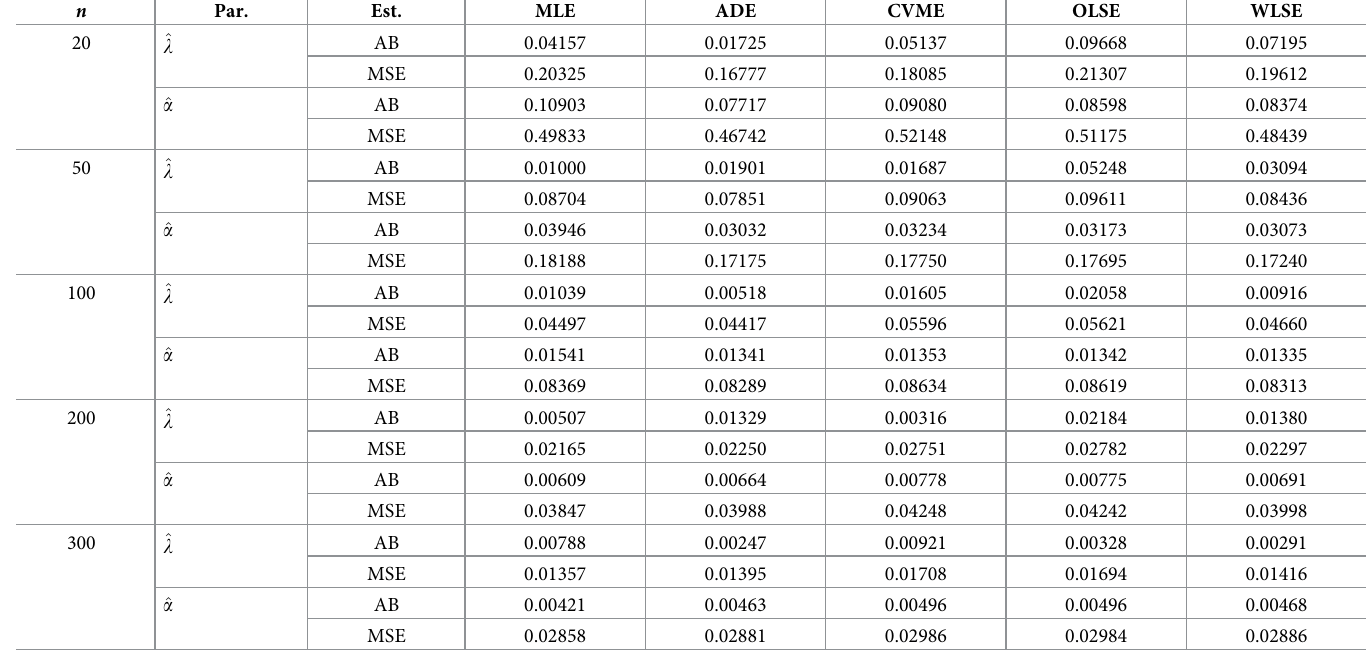
Table 6. Simulation results for ( λ = 0.5, α = 3.0). n